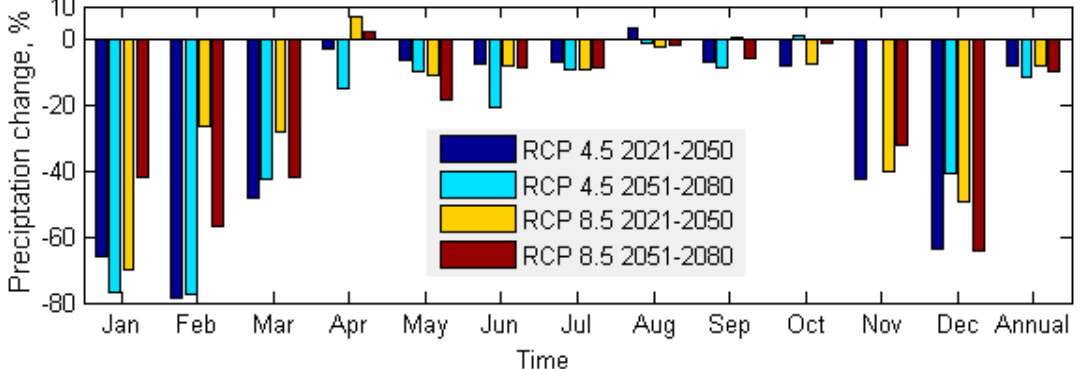
Figure 6. Percentage change of projected average precipitation in Finchaa catchment for 2021–2050 2051–2080 under RCP4.5 and and 2051–2080 under RCP4.5 and RCP8.5.